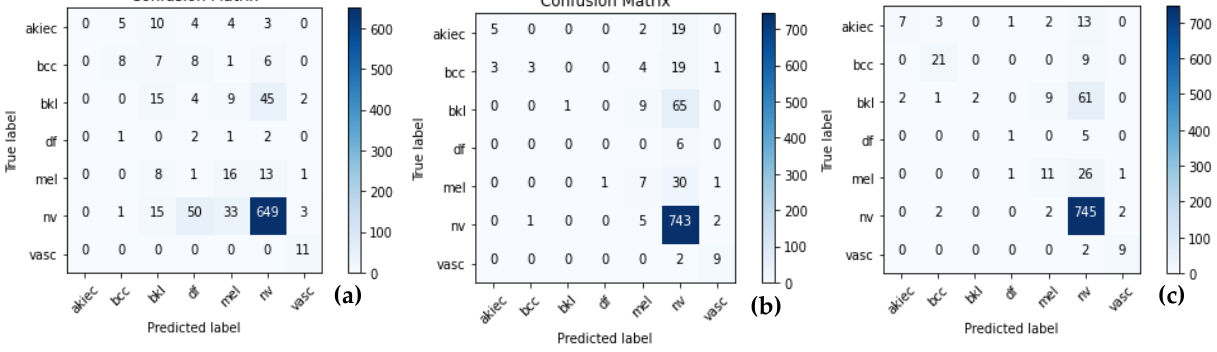
Figure 12. Comparisons of various state-of-the-art systems, where subfigure ( a ) shows the AlexNet [8], ( b ) shows the MobileNet-LSTM [10], and ( c ) the EfficientNet [12] models.